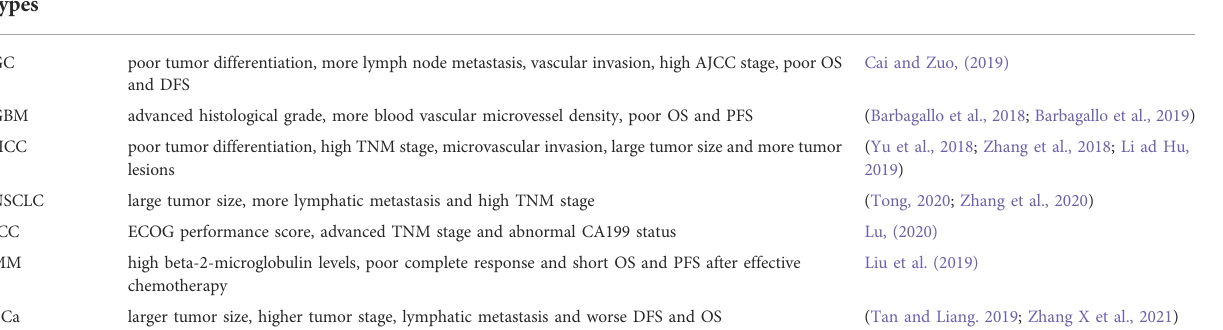
TABLE 2 The clinicopathological features of circSMARCA5 in several human cancers. Tumor